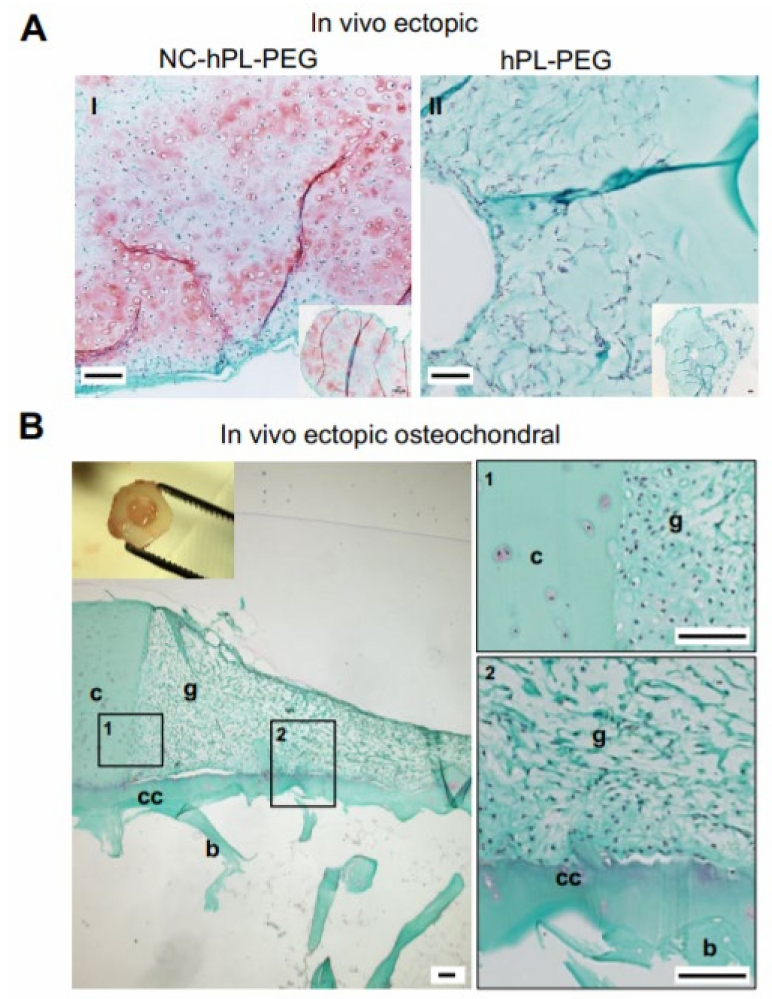
Figure 5. Cartilage forming capacity and integration capacity of the constructs in vivo. Platelet- lysate-containing (hPL-PEG) gels with or without (as control) nasoseptal chondrocytes were im- planted in the subcutaneous pocket of nude mice, without preculturing, alone (ectopic, A ) or injected into a cartilage defect generated in a human osteochondral tissue explant (ectopic human osteo- chondral model, ( B ) (see Materials and Methods for details). ( A ) Safranin-O staining of resulting cell-based ( I ) and cell-free ( II ) constructs. Scale bars = 100 µ m. The insert is a low magnification image of the entire construct. ( B ) Safranin-O staining of explants. The inset shows the combined construct at the time of explantation. Images “1” and “2” are high magnification pictures of areas “1” and “2” on the low magnification image (on the left). Scale bars = 100 µ m; c = native cartilage, b = native bone, cc = native calcified cartilage, g = NC-hPL-PEG